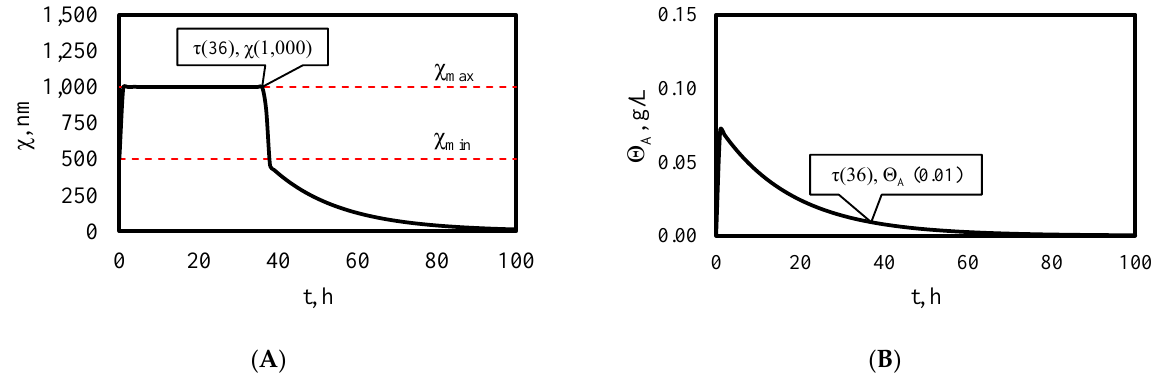
Figure 4. Route of the state of lubrication system without a regulator for 2 L of lubricant in oil pan. ( A ) Tribofilm thickness profile and ( B ) profile of the difference in partial densities of lubricant precursors between the crankcase and the engine.